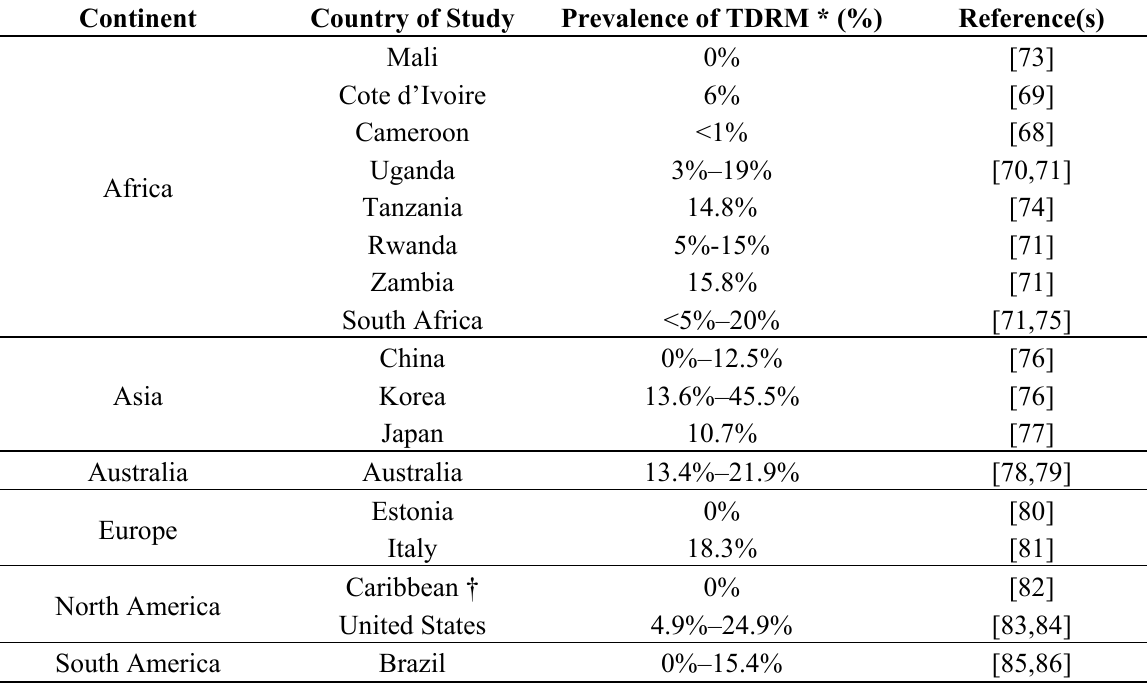
Table 1. Prevalence of drug resistance mutations in HIV treatment-naïve patients worldwide. Continent Country of Study